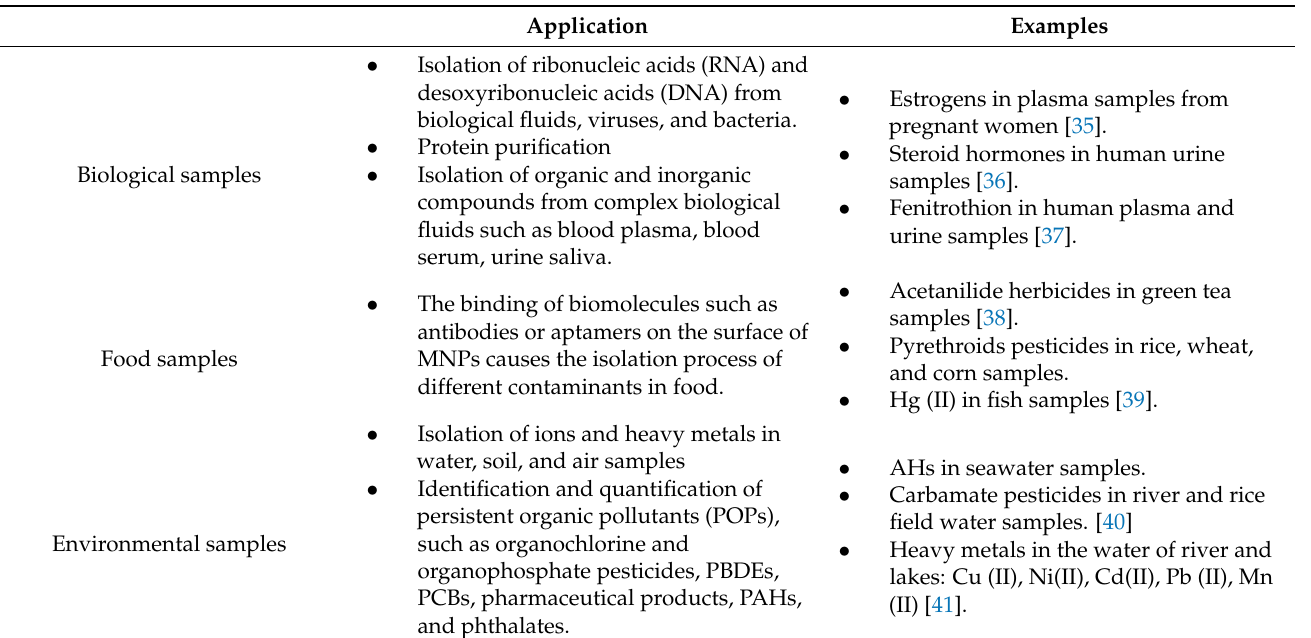
Table 5. Main applications of